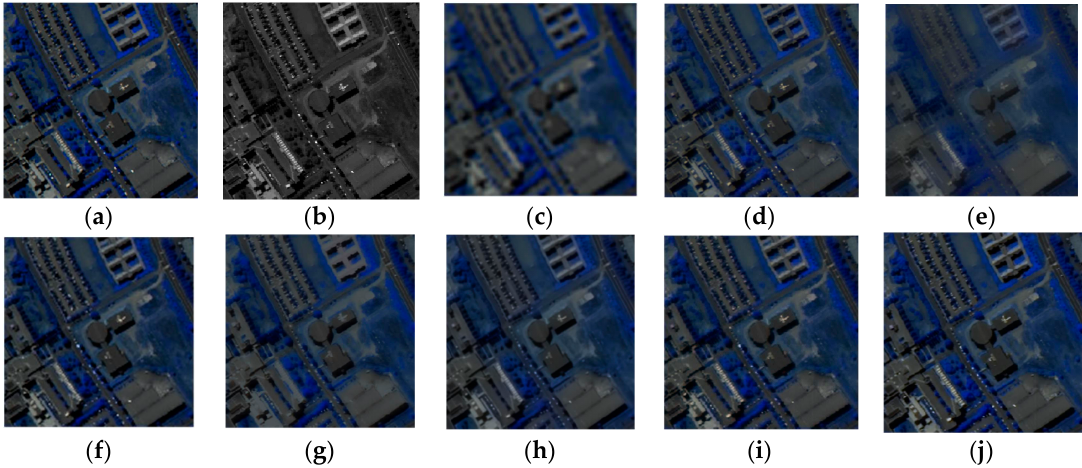
Figure 5. Fusion results obtained by each method for Pavia University dataset. ( a ) Reference HS image; ( b ) Simulated PAN image; ( c ) Interpolated HS image; ( d ) PCA; ( e ) GFPCA; ( f ) BT; ( g ) CNMF; ( h ) BSF; ( i ) MGH; ( j ) STF.